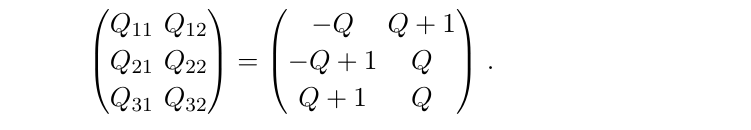
Figure 7 . Effective decay constant in the units of the Planck mass, as a function of τ 1 = τ 2 / for the cases Q = 10 , 20 , 30 , 40 (respectively from below), using the charge ansatz (4.51). We take N 1 = 16 and N 2 = 14